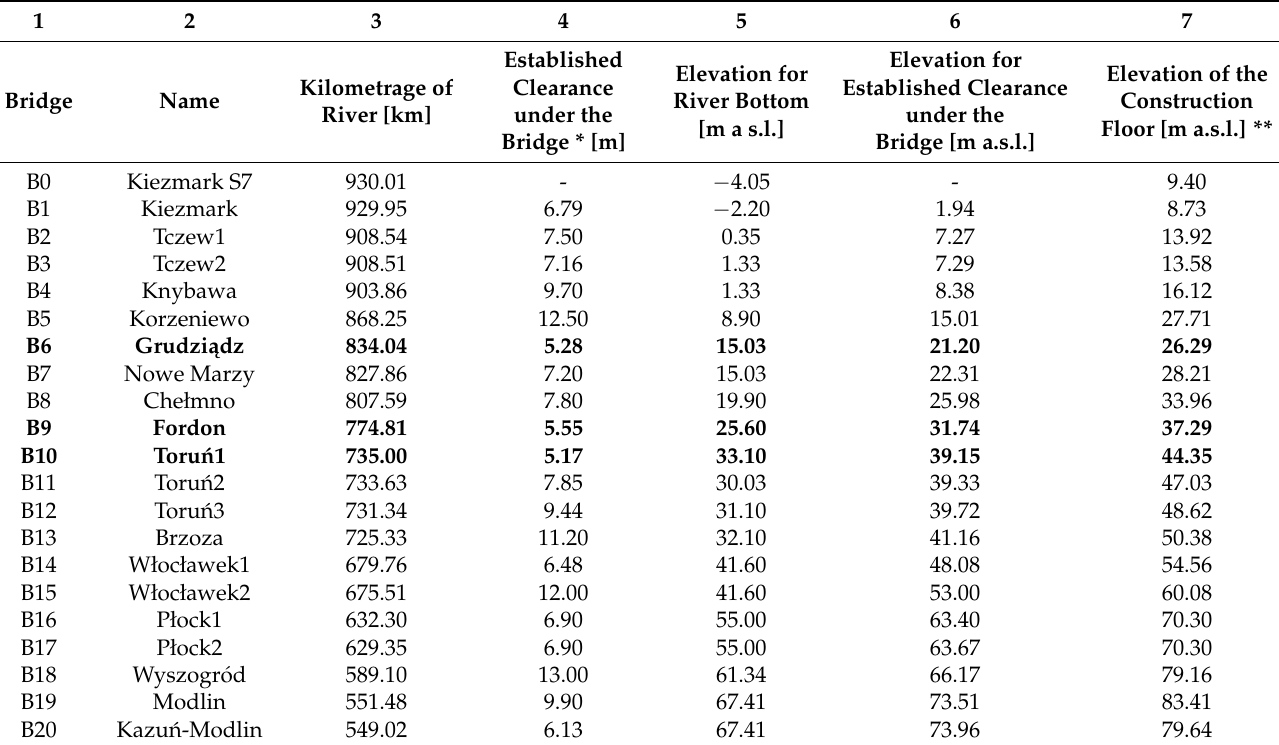
Table 2. Bridge parameters are important for safe navigation—on a stretch of the Vistula River from the estuary to Warsaw.